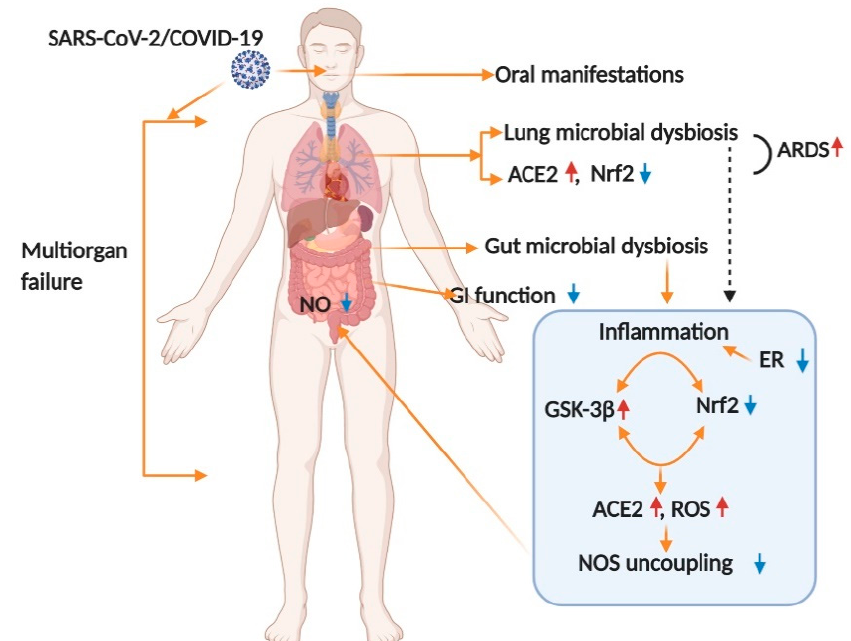
Figure 3. Schematic representation of the proposed mechanism involved in COVID-19-infection inducing multiple organ failure. Binding of viral protein to Angiotensin Converting Enzyme 2 (ACE-2) leads to virus entry. ACE-2 gene expression in oral tissues [46,47], lungs [48,49], vascular [71], kidney [50], stomach [51], and colon [52] has been shown to repress nuclear factor erythroid 2–related factor 2 (NRF2) [53]. A possible mechanism of ACE-2 and reactive oxygen species (ROS) activation by COVID-19 and the repressing of NRF2 executes oral manifestations, acute respiratory distress syndrome (ARDS) in lungs, inflammation and oxidative stress in multiple organs. Suppression of estrogen receptors (ER) by COVID-19 infection elevates inflammation in multiple organs. Suppression of NRF2 by COVID-19 infection reduces tetrahydrobiopterin (BH 4, a cofactor for nitric oxide synthase) availability, nitric oxide synthases (NOS) uncoupling, thus altering overall gastrointestinal (GI)